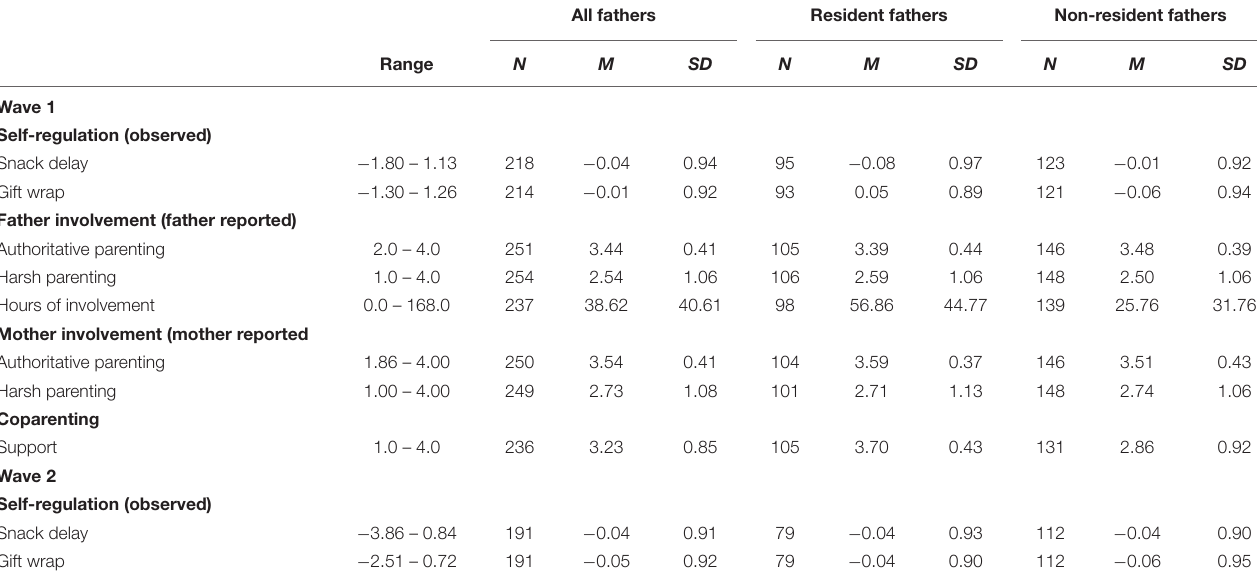
TABLE 1 | Means and descriptive statistics of father involvement and child self-regulation by fathers’ residential status.